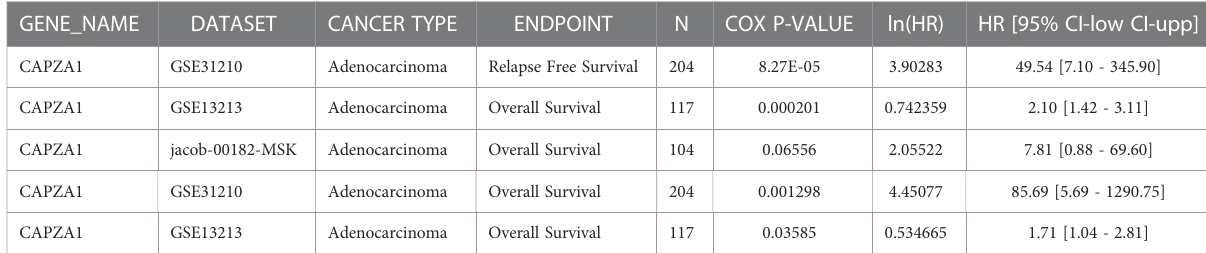
TABLE 1 The Prognostic value of CAPZA1 in lung adenocarcinoma in